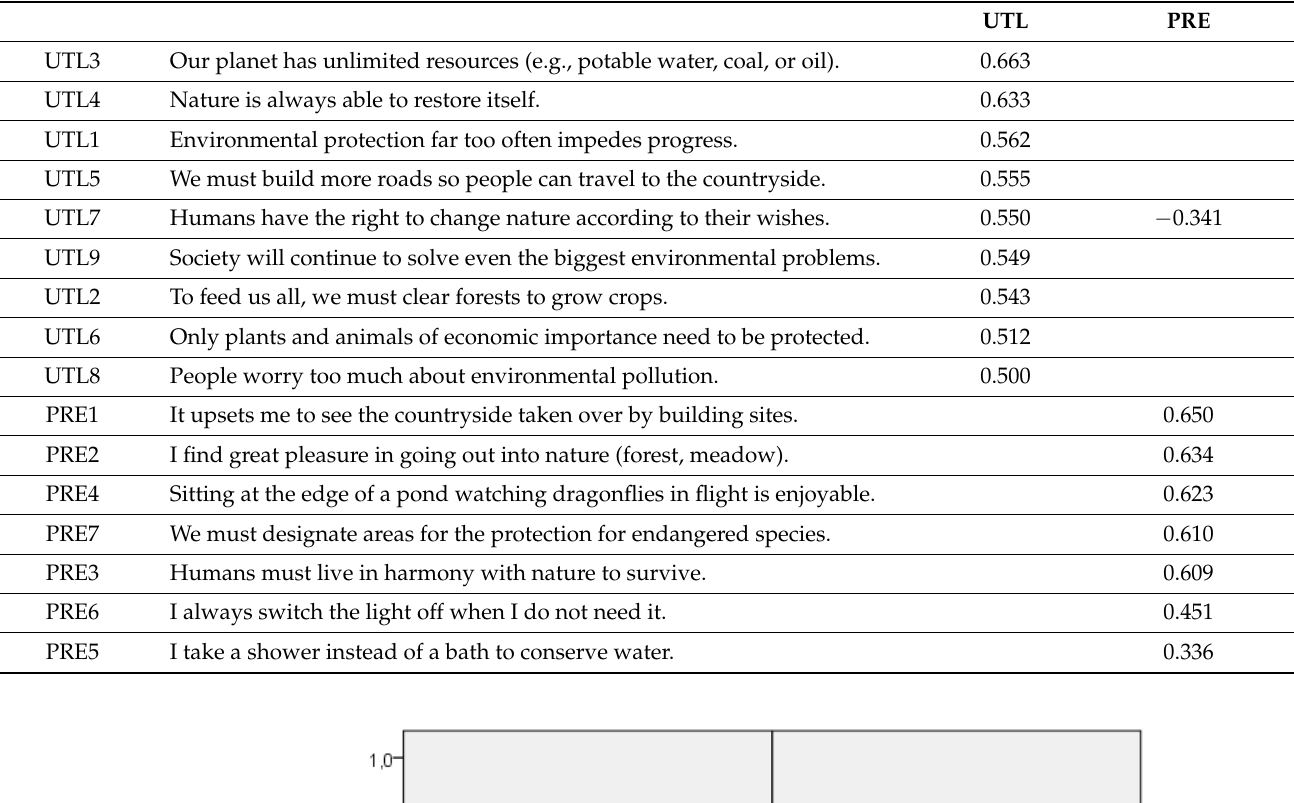
UTL Table 2. Factor loadings of the items to the two major environmental values Utilization (UTL) and Preservation (PRE).